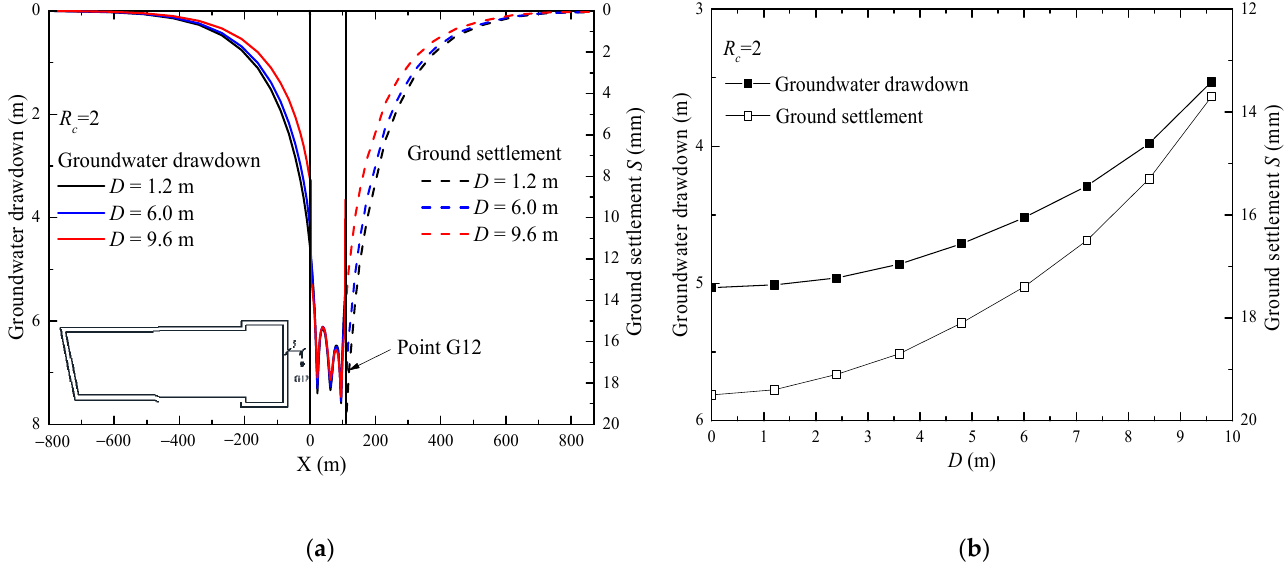
Figure 8. Groundwater drawdown and ground settlement with different value of D : ( a ) Section I-I; ( b ) Point G12.